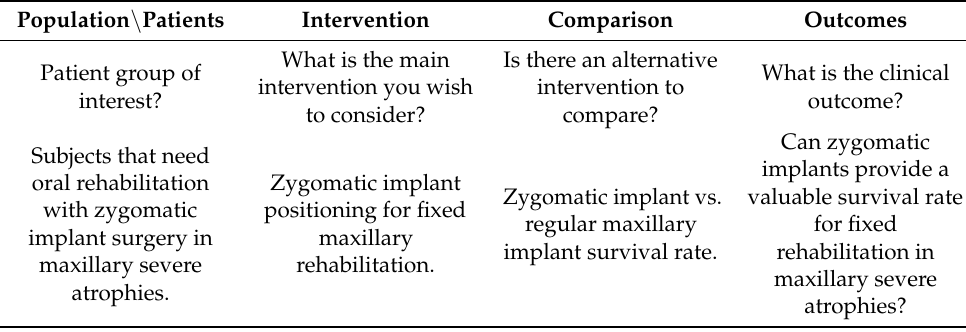
Table 1. The PICO (population, intervention, comparison, outcome) question. Population \